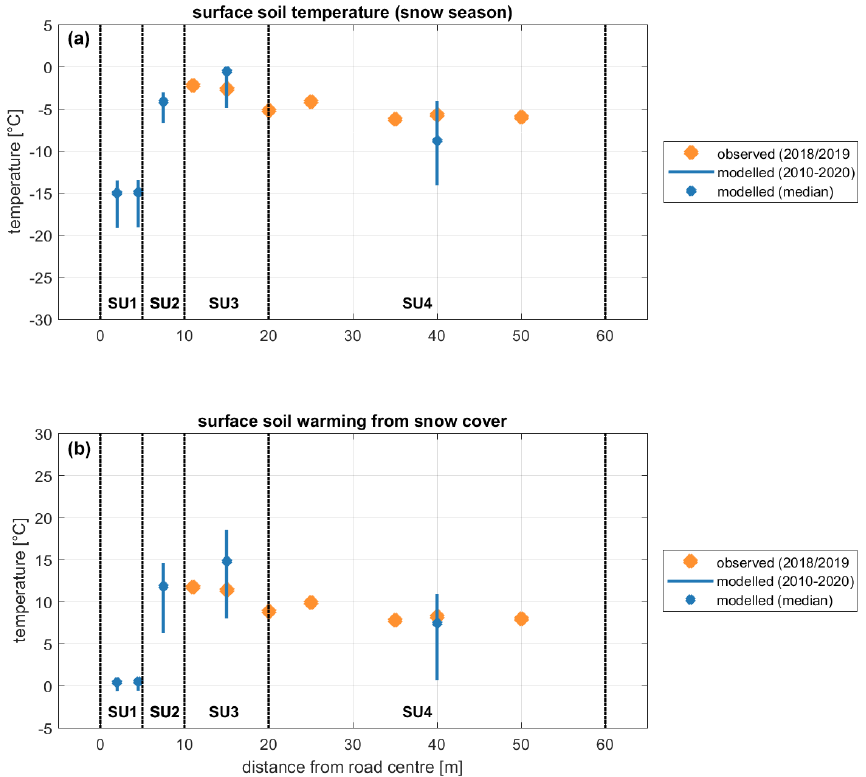
Figure A2. Transect of modelled (MedRes conservative setting) and observed soil surface temperatures for increasing distances from the road centre. Panel (a) shows modelled and observed soil surface temperatures averaged over the snow season (1 November to 30 April). Panel (b) shows the difference of snow-season surface soil minus surface air temperature. Blue dots and blue lines illustrate simulated year-to-year variability and indicate the median and min–max range estimated from 11 snow seasons simulated by CryoGrid3 for the period 2010 to 2020, and orange dots give estimates based on iButton measurements (Dalton highway, Alaska) for the snow season 2018–2019. The dotted vertical black lines illustrate the structural unit domains (SU1: road centre, SU2: embankment shoulder, SU3: toe, SU4: adjacent tundra).